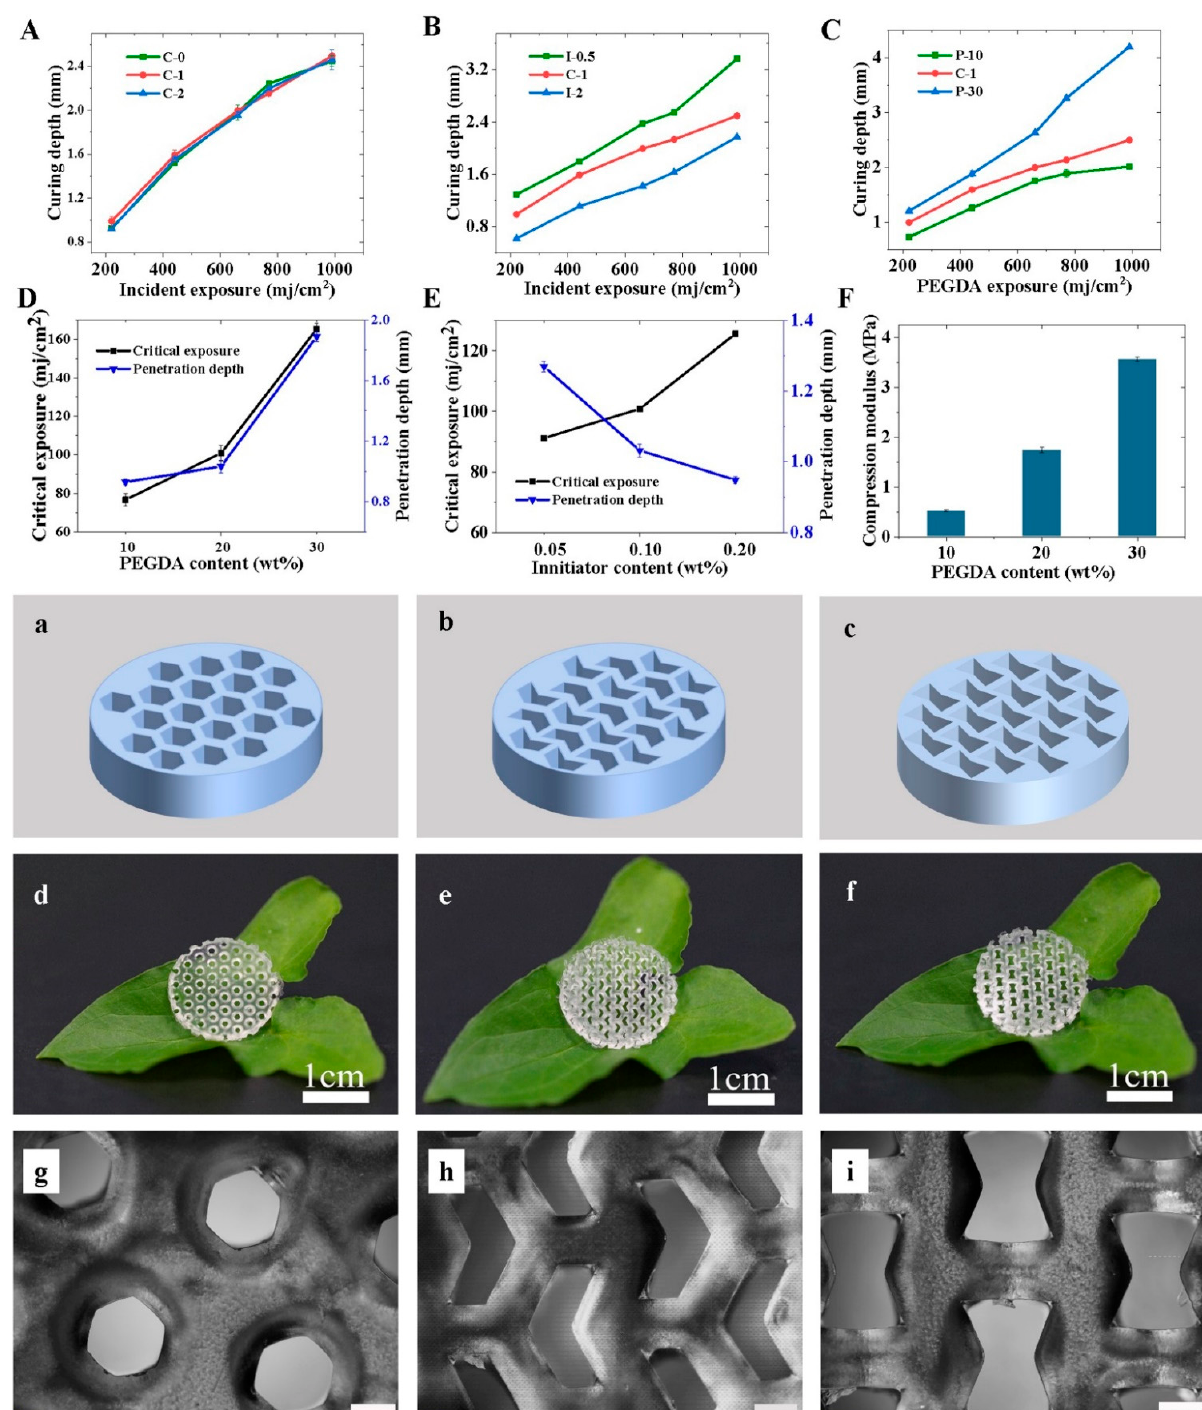
Figure 2. Adjustment of the material ratio of the CNF/PEGDA ‐ blend photocurable resin during the photocuring process. ( A – C ) Relationship between curing depth and incident exposure for blended photocurable resins with different material ratios: ( A ) CNF content; ( B ) initiator content; ( C ) PEGDA content. ( D – E ) Effect of initiator content and PEGDA on the critical exposure (Ec) and penetration depth (Dp) of CNF/PEGDA blended photocurable resins: ( D ) CNF content 1% and PEGDA content 20 wt%; ( E ) CNF content 1% and initiator content 0.1 wt%. ( F ) Compression modulus of CNF/PEGDA hydrogel at different PEGDA content levels. ( a – f ) Ideal and actual CNF/PEGDA hydrogels: ( a – c ) ideal hydrogels; ( d – f ) actual hydrogels. ( g – i ) Optical microscopy of CNF/PEGDA hydrogel; the scale is 500 µ m. Left to right: ( a , d , g ) PPR; ( b , e , h ) ZPR; ( c , f , i )